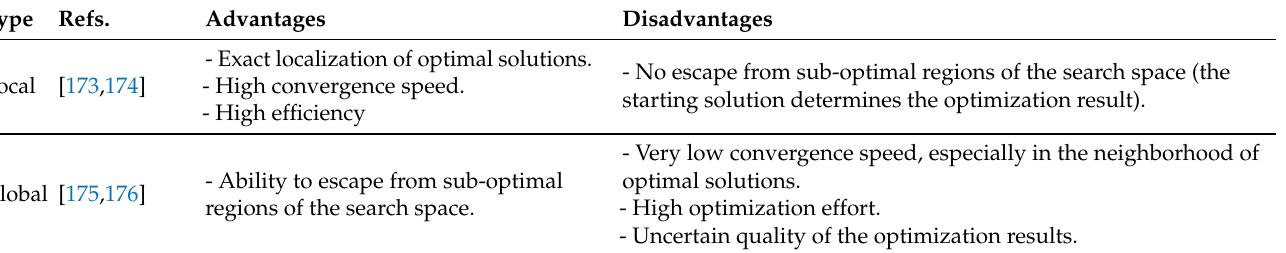
Table 12. Advantages and disadvantages of local and global optimization algorithms. Type